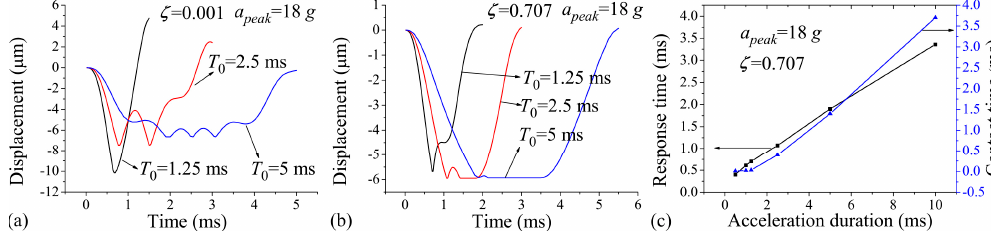
Figure 4. Displacement vs. time for ( a ) ζ = 0.001 and ( b ) ζ = 0.707 when a peak = 18 g , T 0 = 1.25 ms, 2.5 ms, and 5 ms, respectively; ( c ) Contact time vs. acceleration duration and response time vs. acceleration duration when a peak = 18 g and ζ = 0.707.